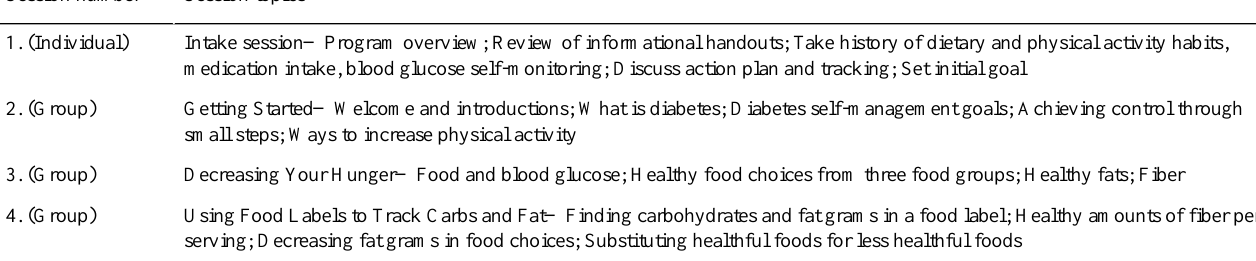
Table 1. Women in Control diabetes self-management program outline. Session topicsSession